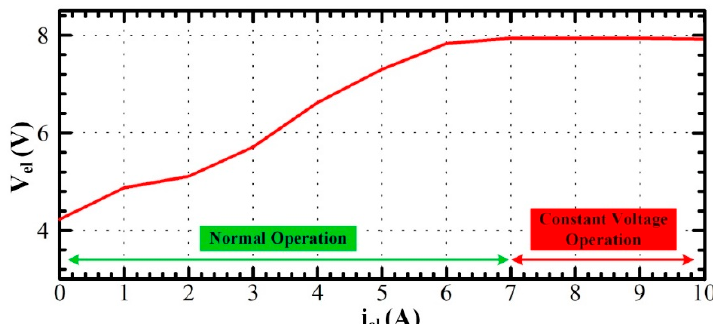
Figure 1. Static voltage-current waveform.